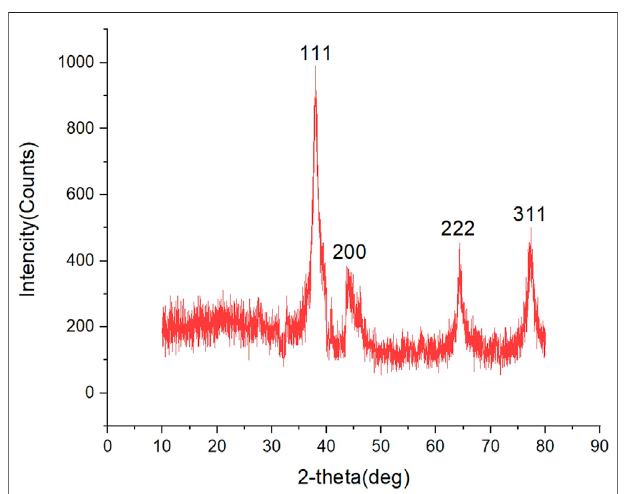
FIGURE 7 | XRD patterns of biosynthesized